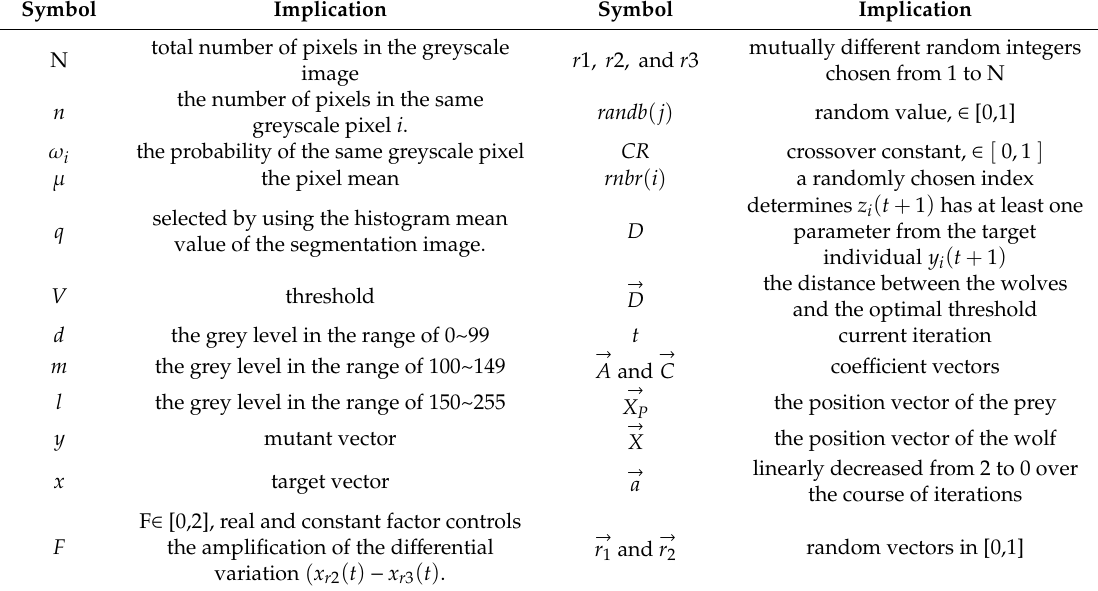
Table 1. The implication of the formula symbol in Section